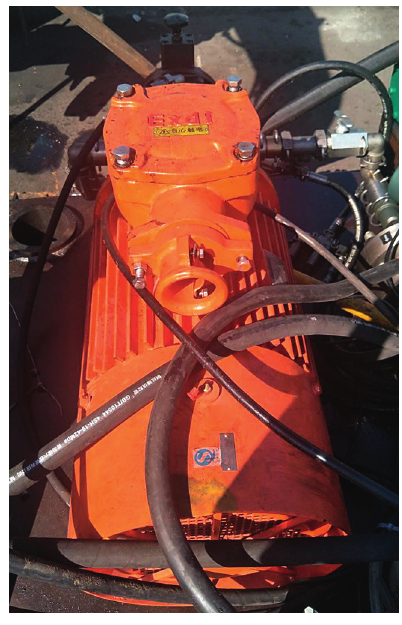
Figure 14: Double piston rotary motor.